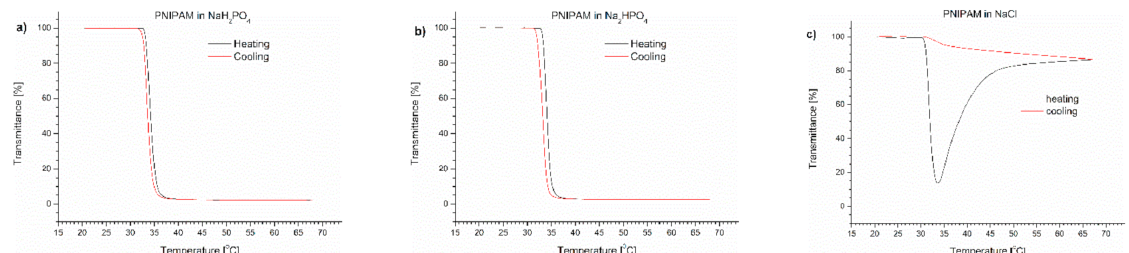
Figure 3. Transmittance versus temperature curves of solutions of PNIPAM in ( a ) monosodium phosphate, ( b ) disodium phosphate, ( c ) NaCl. Total solute concentration: 0.5 g/L; heating/cooling rate: 1 ◦ C/min. Heating: black; cooling: red.